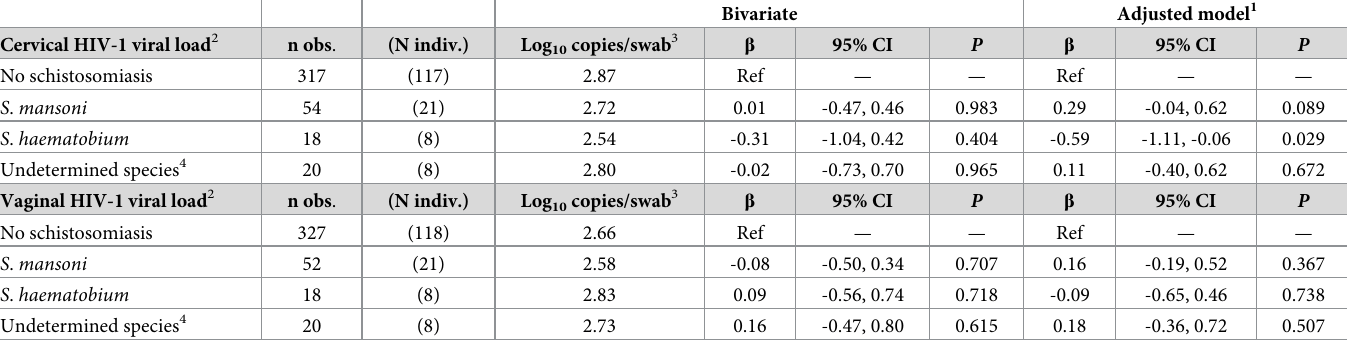
Bivariate Adjusted model 1